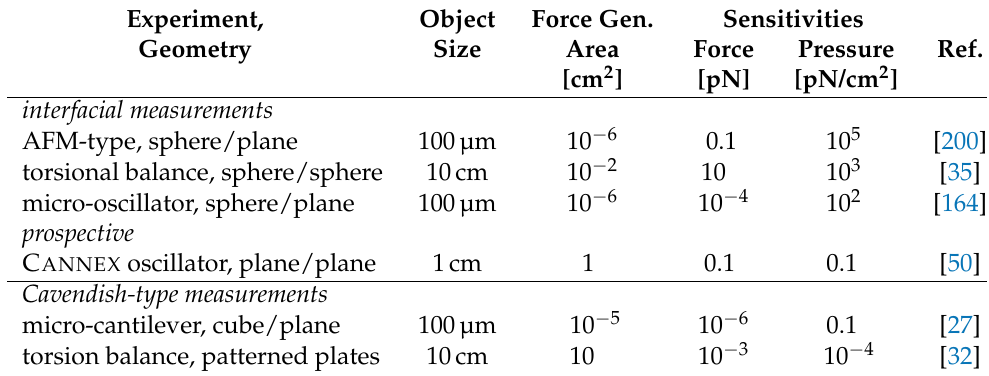
Table 1. Order-of-magnitude-comparison of several present experimental setups in terms of geometry, size of the force-generating area A eff , and sensitivity to forces and